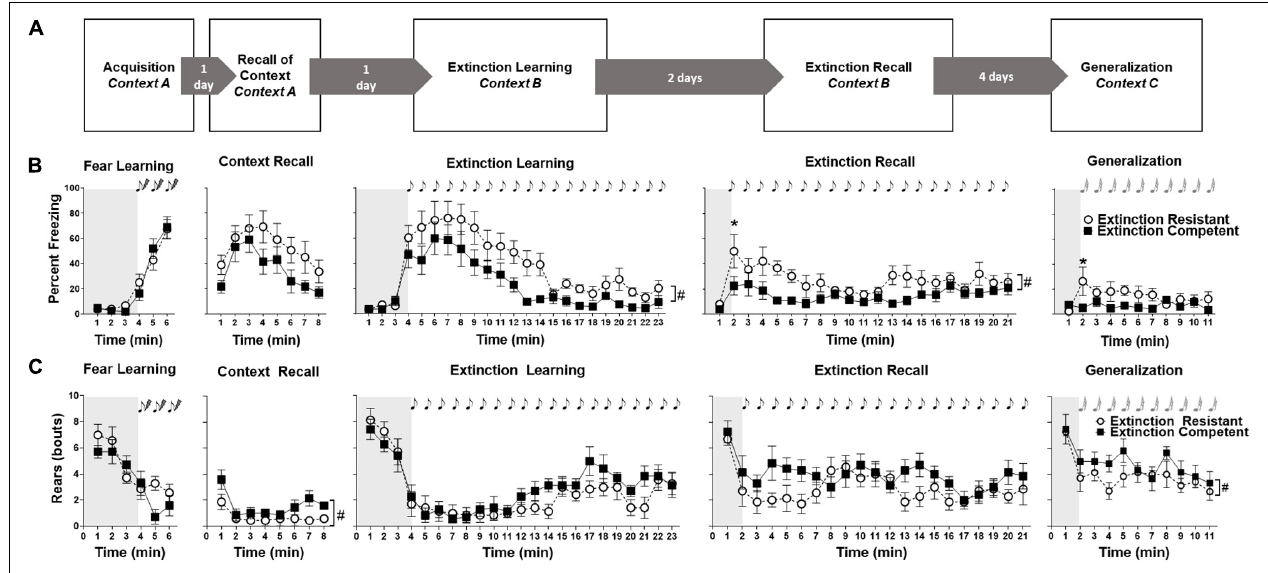
FIGURE 1 | Testing protocol is shown in panel (A) . Freezing (B) and rearing (C) behaviors in extinction competent (EC) and extinction resistant (ER) rats are shown during fear acquisition, contextual recall, extinction learning, extinction recall, and generalization trials. Shaded area represents the unconditioned period before the tone–shock pairings (fear learning) or the first conditioned/novel tone (extinction learning, extinction recall, and generalization). Freezing behavior is expressed as percent freezing in 1-min bins while rearing is the number of rears during each minute. EC and ER rats showed no differences in freezing (A) during acquisition or context recall, but ER rats displayed higher freezing in response to the CS+ (tone) than EC rats during extinction learning and extinction recall. A time by phenotype interaction in freezing was seen during generalization since ER rats exhibited higher freezing than EC rats, but only during the first novel tone presentation during this trial. Bouts of rearing (C) decreased across time during all trials as demonstrated by main effects of time, since rearing was high during periods before the tone presentation (shaded areas) and decreased as freezing behavior increased. Overall differences in rearing bouts between ER and EC groups were only seen during contextual fear extinction, and generalization. Points represent mean ± SEM, with N = 7 ER and N = 7 EC rats per group. # P < 0.05 for main ER–EC difference; * P < 0.05 significant differences at each time point. Tones are denoted by the